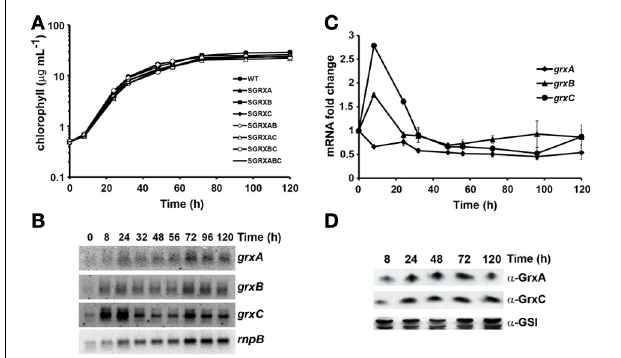
FIGURE 1 | Glutaredoxins are not essential under standard growth conditions. (A) Semi-logarithmic representation of growth of Synechocystis glutaredoxin mutants strains under standard conditions. WT ( • ), SGRXA ( (cid:2) ), SGRXB ( (cid:3) ), SGRXC ( (cid:4) ), SGRXAB ( ♦ ), SGRXAC ( (cid:3) ), SGRXBC ( (cid:4) ), and SGRXABC ( − ) strains were inoculated at 0.5 μ g chlorophyll mL − 1 and growth was monitored by measuring chlorophyll content. (B) Northern blot analysis of grxA , grxB, and grxC expression along the growth curve. Total RNA was isolated from WT cells grown in BG11C at the indicated times. The filter was hybridized with grxA , grxB, and grxC probes and subsequently stripped and re-hybridized with an rnpB probe as a control. (C) Quantification of relative mRNA levels of grxA , grxB, and grxC during the growth curve. Radioactive signals were quantified and normalized to the rnpB signal. Plots of relative mRNA levels vs. time were drawn; data represent average of 3 independent experiments and error bars represent SE. grxA ( (cid:4) ), grxB ( (cid:2) ), and grxC ( • ). (D) Western blot analysis of GrxA and GrxC levels during the growth curve. WT cells were grown in BG11C medium and cells were harvested at the indicated times. Fifteen microgram of total protein from soluble extracts were separated by 15% SDS-PAGE and subjected to western blot to detect GrxA, GrxC, and